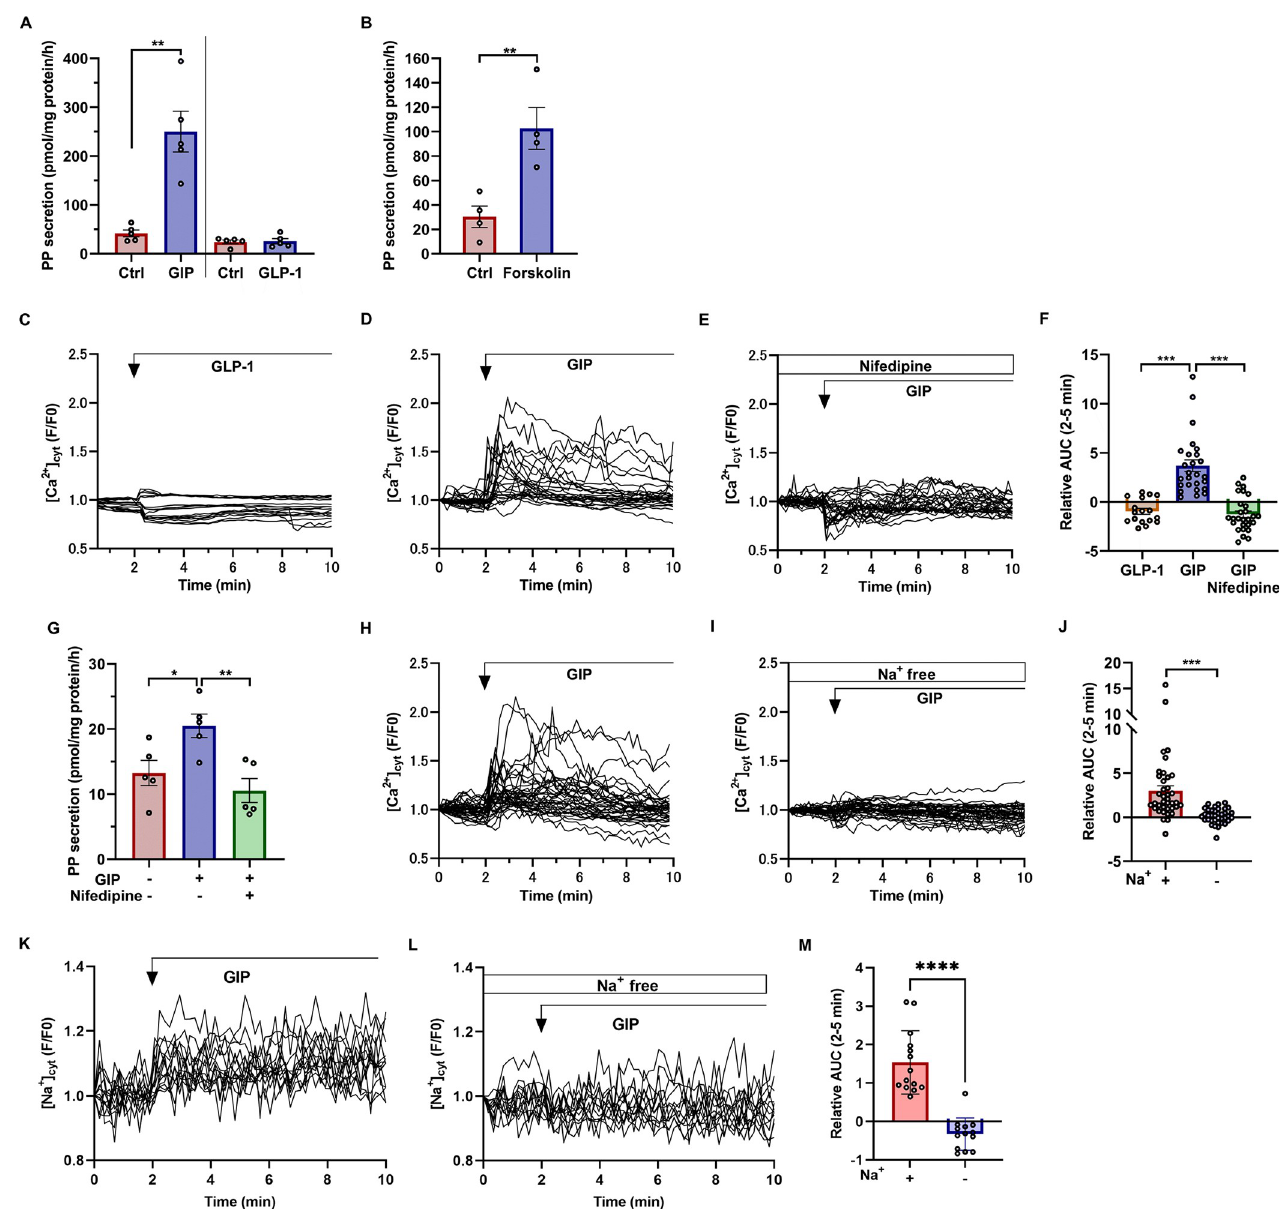
Fig 6. GIP-stimulated PP secretion. (A) PP secretion from islets in the head region of the pancreas of 10-week-old WT mice stimulated with 10 nM GIP (n = 5 mice, left side), or 10 nM GLP-1 (n = 5 mice, right side) for 1 hour. (B) PP secretion from islets in the head region of the pancreas of 8 to 13-week-old WT mice stimulated with 40 μ M forskolin (n = 4 mice). (C-E) Representative time courses of Ca 2+ responses in Clover + cells from Ppy-Clover-PEST mice (n = 4) treated with 10 nM GLP-1 (C, n = 17 cells), 10 nM GIP (D, n = 26 cells), or 10 nM GIP and 10 μ M nifedipine (E, n = 27 cells). (F) Ca 2+ responses to stimulation with 10 nM GLP-1 (n = 17 cells), 10 nM GIP (n = 26 cells), or 10 nM GIP and 10 μ M nifedipine (n = 27 cells) in Clover + cells from Ppy-Clover- PEST mice. (G) PP secretion from islets of the head region of the pancreas of 8 to 13-week-old WT mice, stimulated with 10 nM GIP, with or without 10 μ M nifedipine (n = 5). (H, I) Representative time course of Ca 2+ responses in Clover + cells from Ppy-Clover-PEST mice (n = 4) stimulated with 10 nM GIP in HKRB buffer with (H, n = 38 cells) or without (I, n = 37 cells) Na + . (J) Ca 2+ responses to 10 nM GIP stimulation in HKRB medium with or without Na + , in Clover + cells from Ppy-Clover-PEST mice. (K, L) Representative time courses of Na + responses in Clover + cells from Ppy-Clover-PEST mice (n = 4) treated with 10 nM GIP in HKRB buffer with (K, n = 14 cells) or without (L, n = 13 cells) Na + . (M) Na + responses to 10 nM GIP stimulation in HKRB medium with or without Na + , in Clover + cells from Ppy-Clover-PEST mice. PP secretion values were normalized by the amount of protein in islets from the head region of the pancreas. Data are shown as the mean ± SEM, and were analyzed by the unpaired t -test. � p < 0.05, �� p < 0.01, ��� p < 0.001; AUC: Area under the curve.